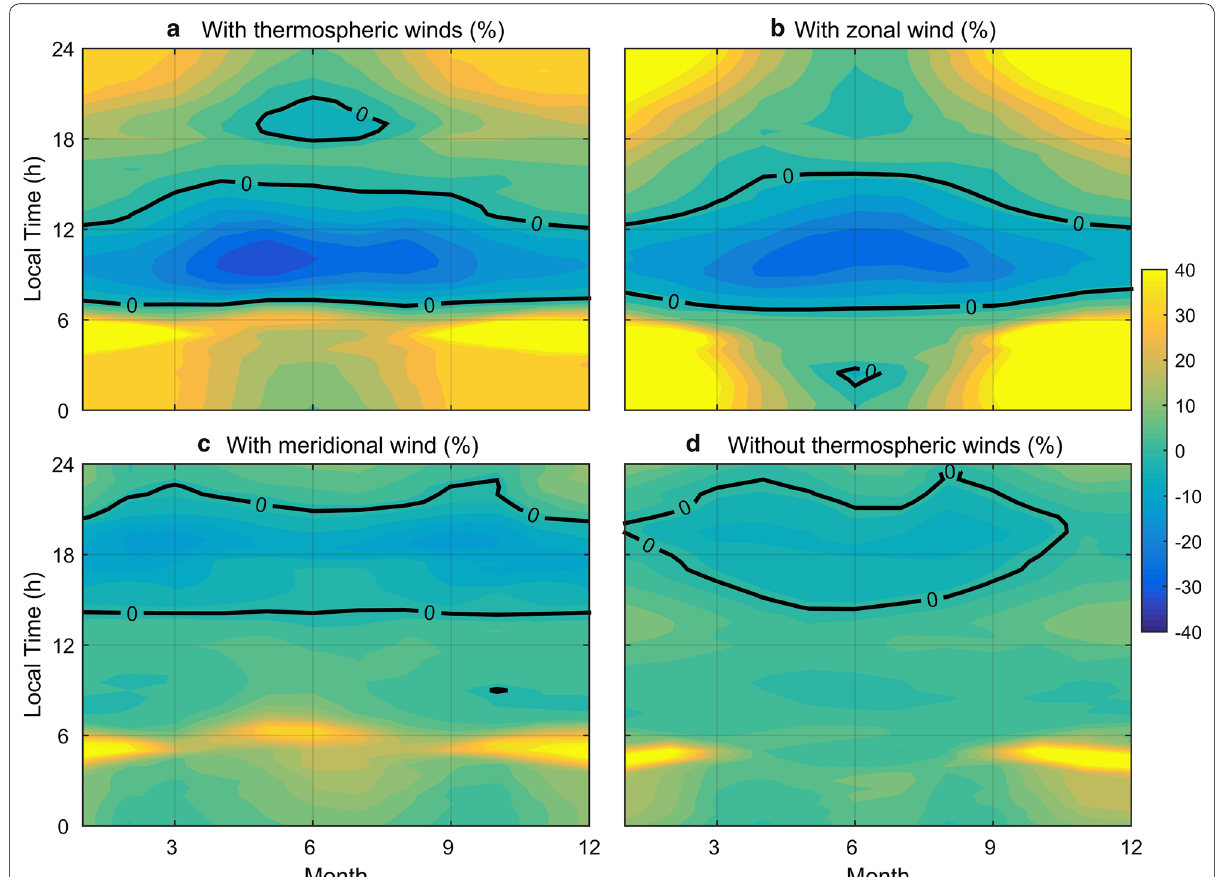
Fig. 3 The seasonal and diurnal variations of R ew (in units of %) driven a by all thermospheric winds, b by thermospheric zonal wind, c by thermospheric meridional wind, and d no thermospheric